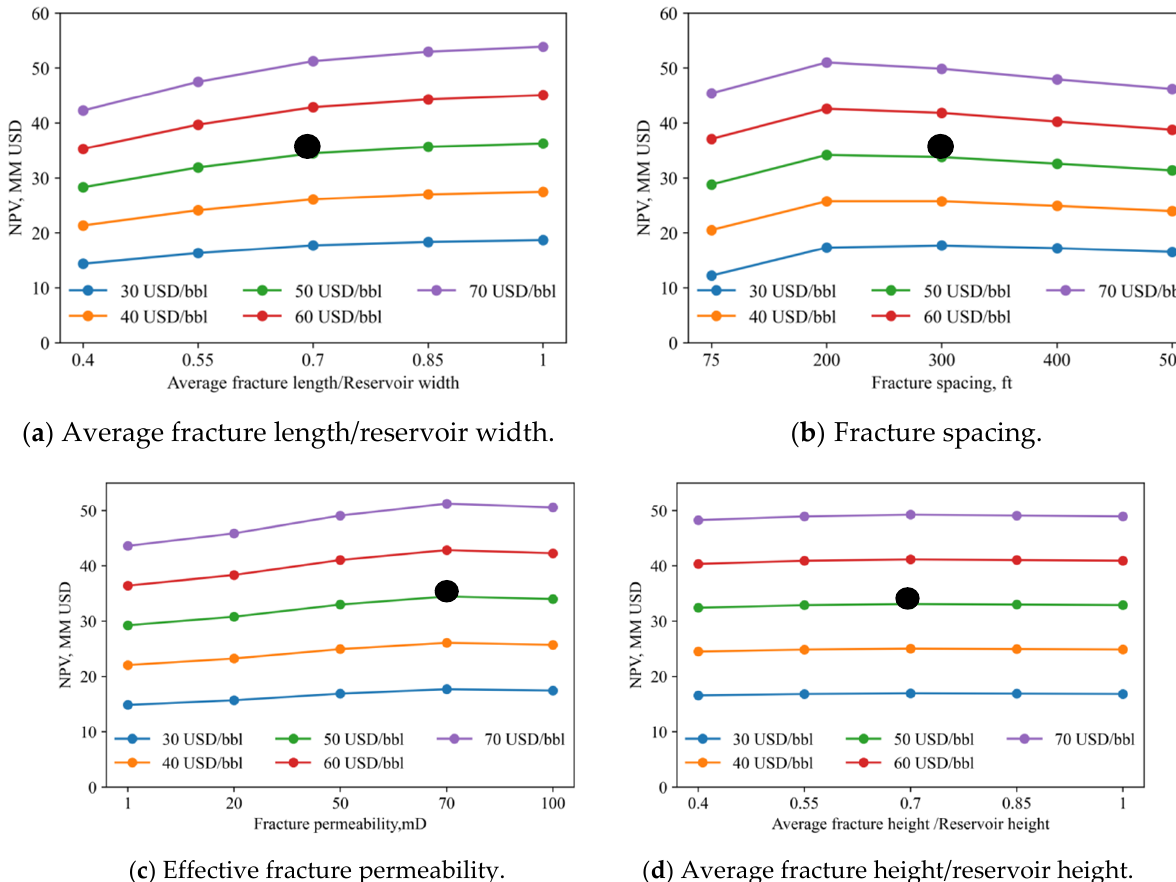
Figure 13. Sensitivity of NPV to fracturing parameters.